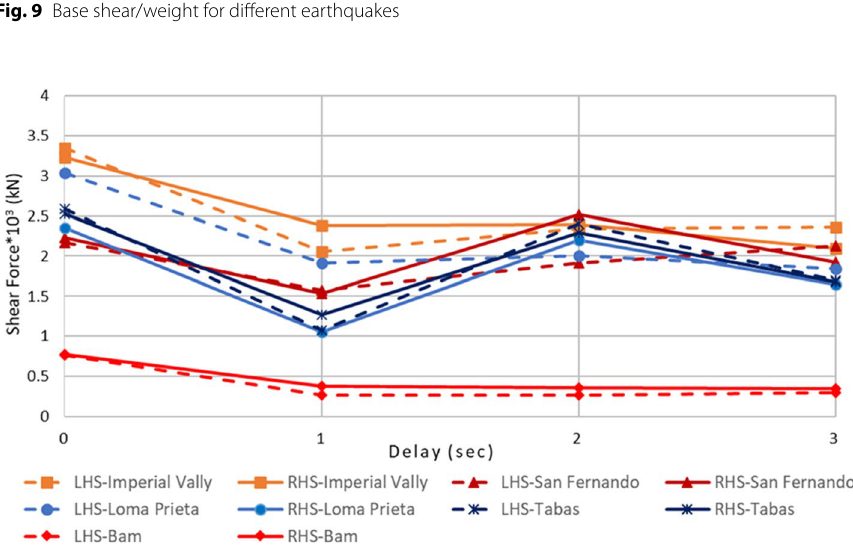
Fig. 10 Maximum shear force at tower bottom under different earthquakes